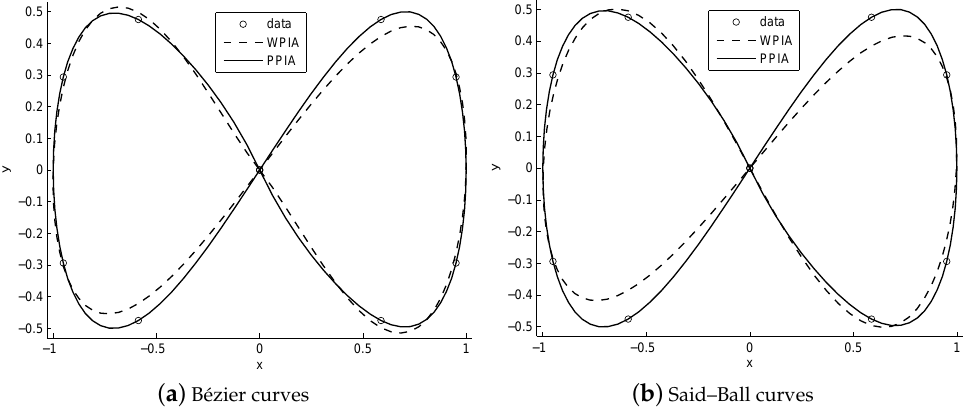
Figure 4. Approximations of the lemniscate of Gerono in Example 1 at the tenth